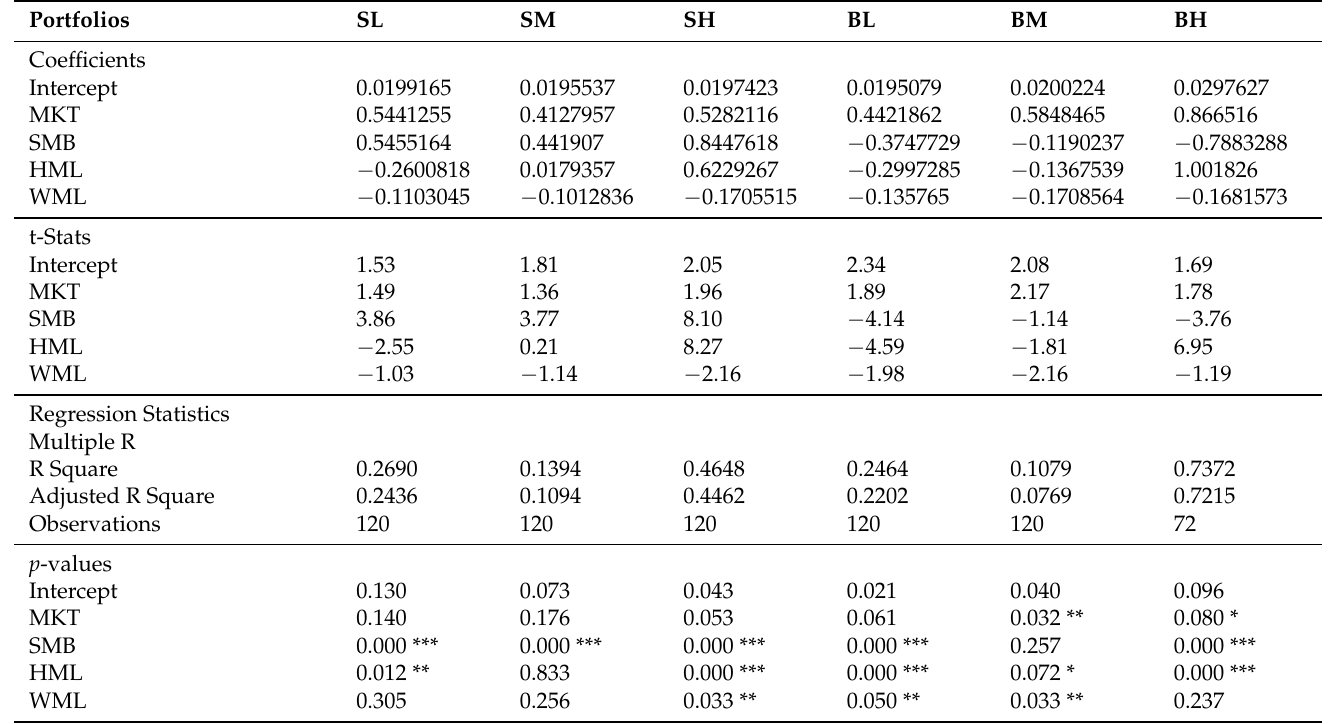
Table 6. Carhart Four-Factor Analysis Regression